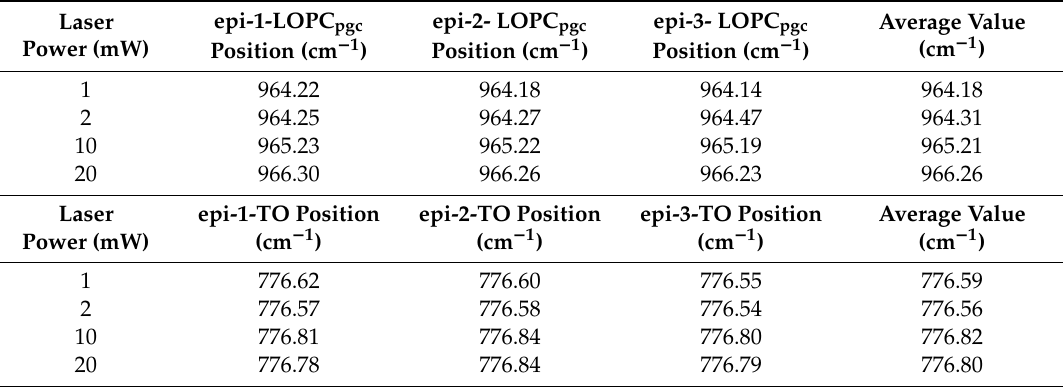
Table 3. Peak position of the Raman LOPC pgc and TO peaks for the epi sample at three di ff erent measurement positions when using the exciting line at 325